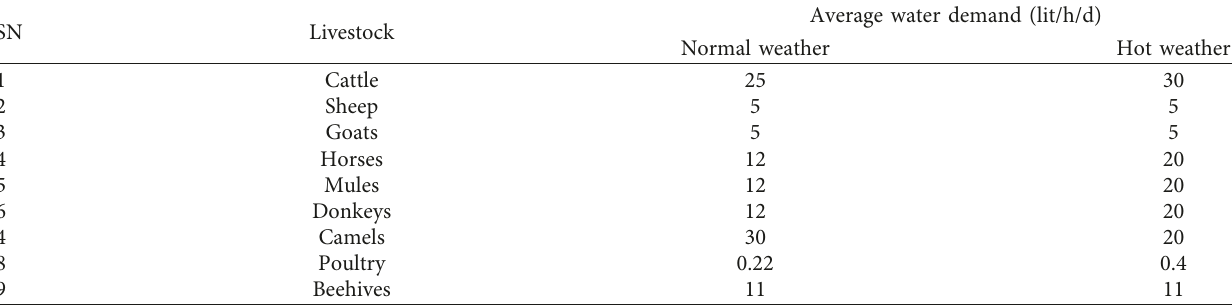
Table 10: Livestock water use rate in liters per head per day (Richard 1995).